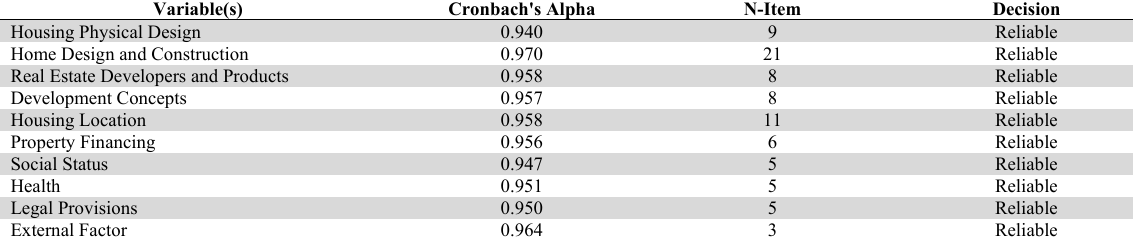
Validity and Reliability of Housing Physical Design